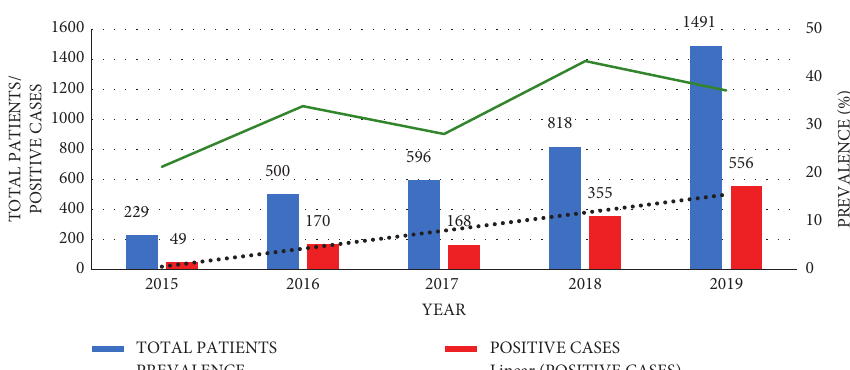
Figure 3: Annual trend of prevalence (%) of H . pylori infection at selected AAR